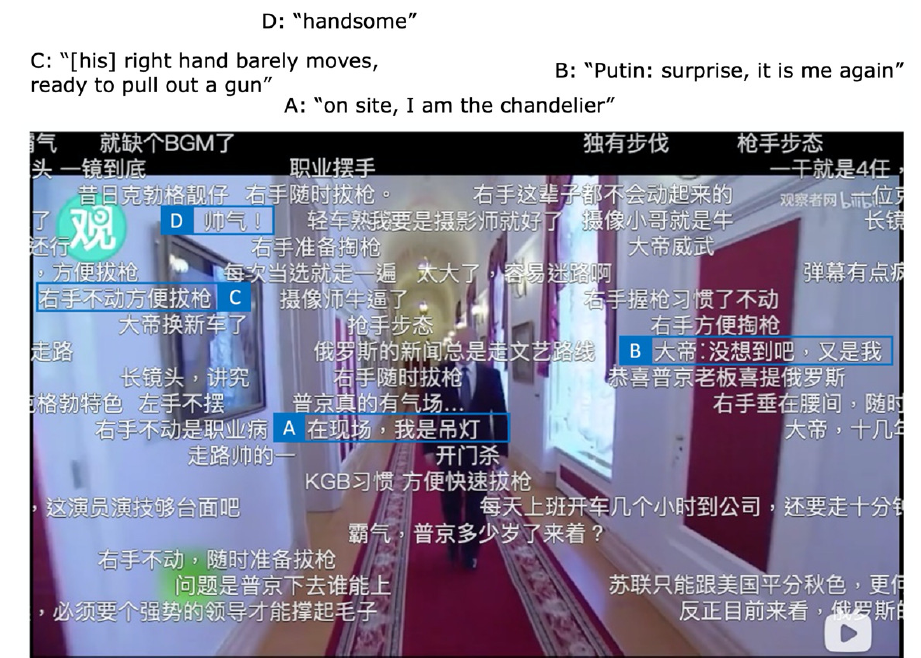
Figure 1. A screenshot of the video titled A Grand Presidential Inauguration Has Taken Place in the Kremlin, Opening Putin’s Fourth Term